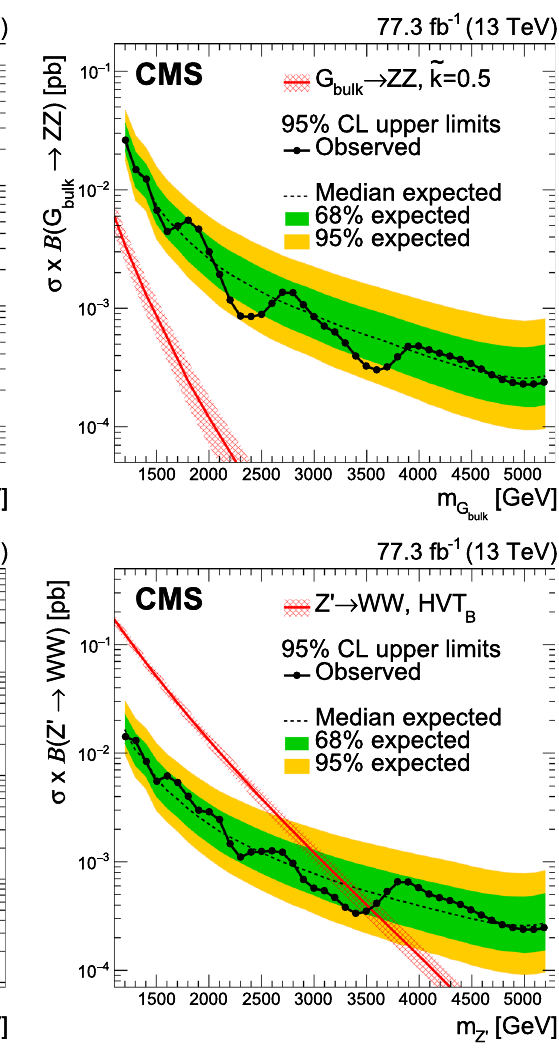
Fig. 12 Observed and expected 95% CL upper limits on the product of the production cross section ( σ ) and the branching fraction, obtained after combining categories of all purities with 77.3fb − 1 of 13TeV data, for G bulk → WW (upper left), G bulk → ZZ (upper right), W (cid:3) → WZ